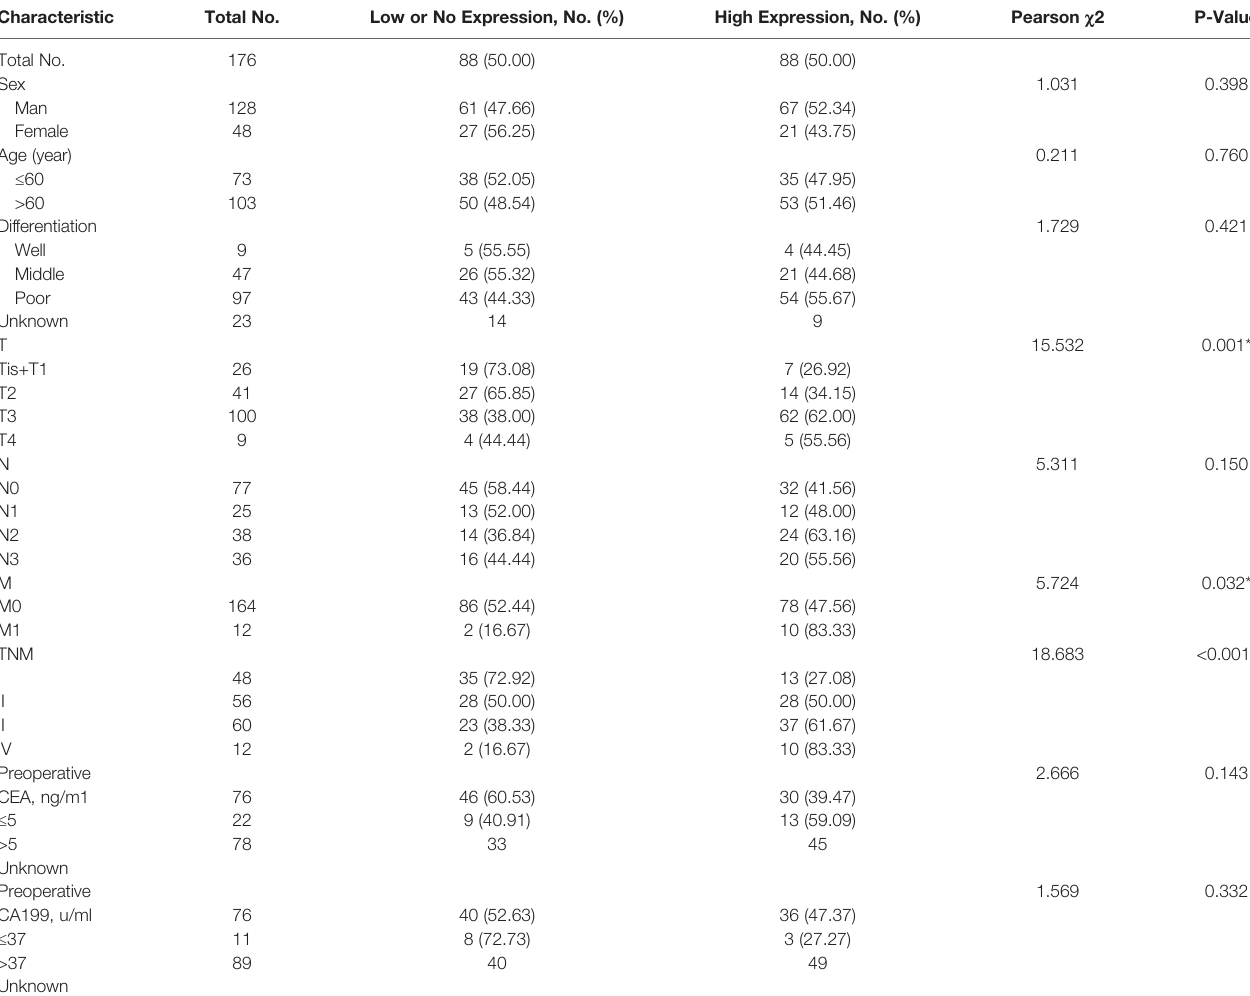
TABLE 1 | Association of glycoprotein a repetitions predominant (GARP) expression levels with clinicopathological characteristics in patients with gastric cancer. Characteristic Total No. Low or No Expression, No. (%) High Expression, No. (%) Pearson c 2 P-Value Total